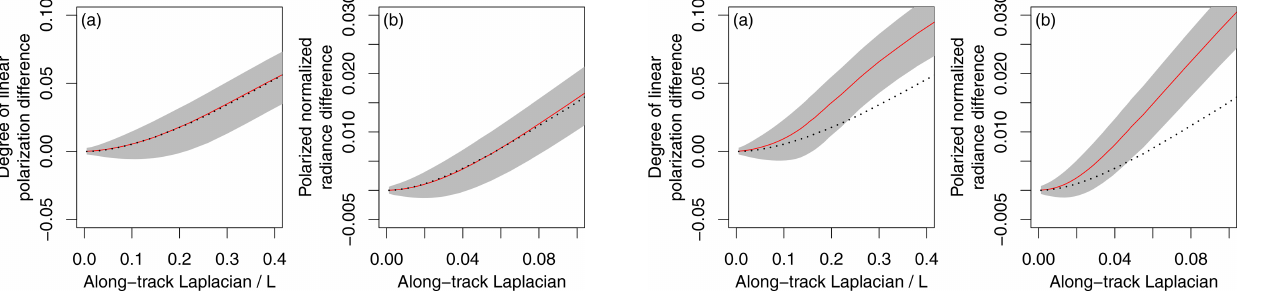
Figure 9. (a) The simulated proxy–reference difference in the de- gree of linear polarization as a function of the along-track Laplacian divided by normalized radiance (b) The simulated proxy–reference difference in the polarized normalized radiance as a function of the along-track Laplacian. Red curves represent median, and gray shad- ing indicates the interquartile range of the simulation. Black dotted curves correspond to the medians of the observation (i.e., red curves in Figs. 6a and 7a).